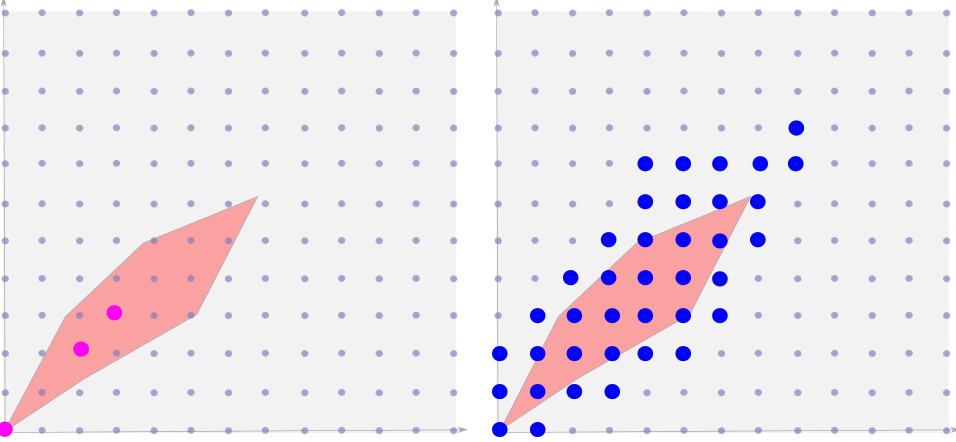
(cid:16)(cid:0) (cid:1) ∗ (cid:17) f + in blue, and Fix ( f ∗ ) is the light red